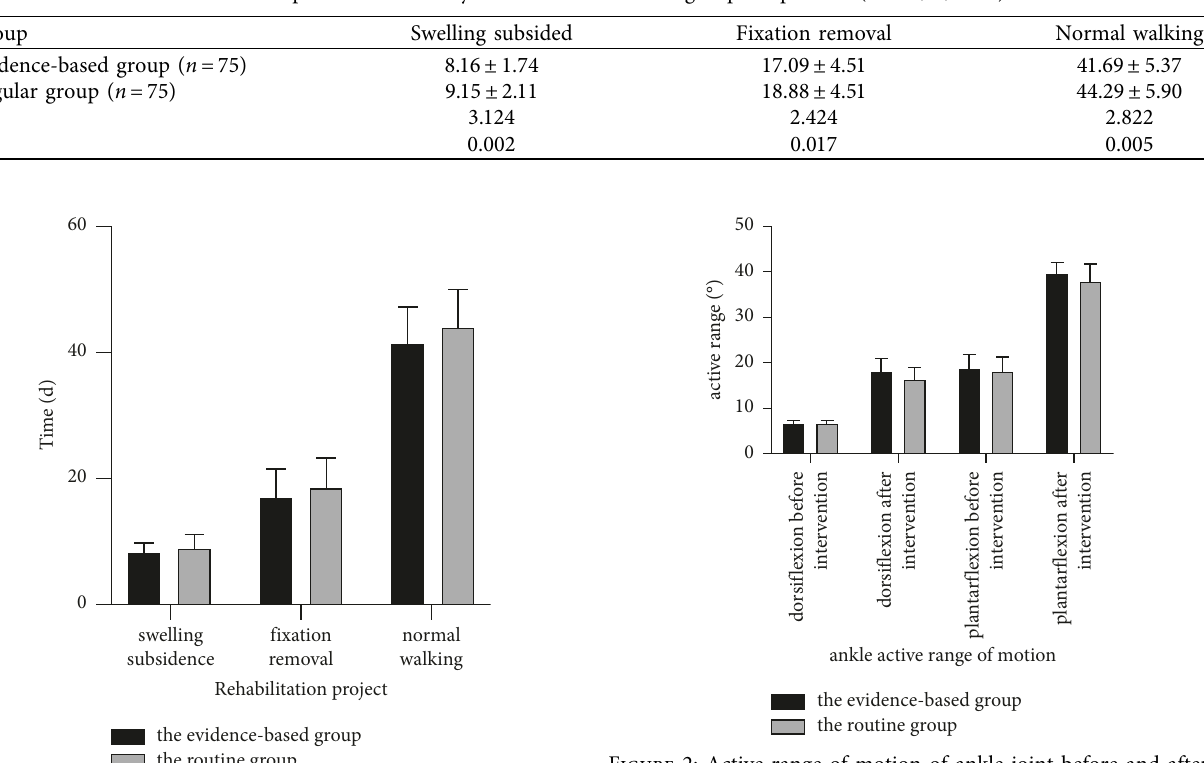
Figure 2: Active range of motion of ankle joint before and after intervention in the two groups of